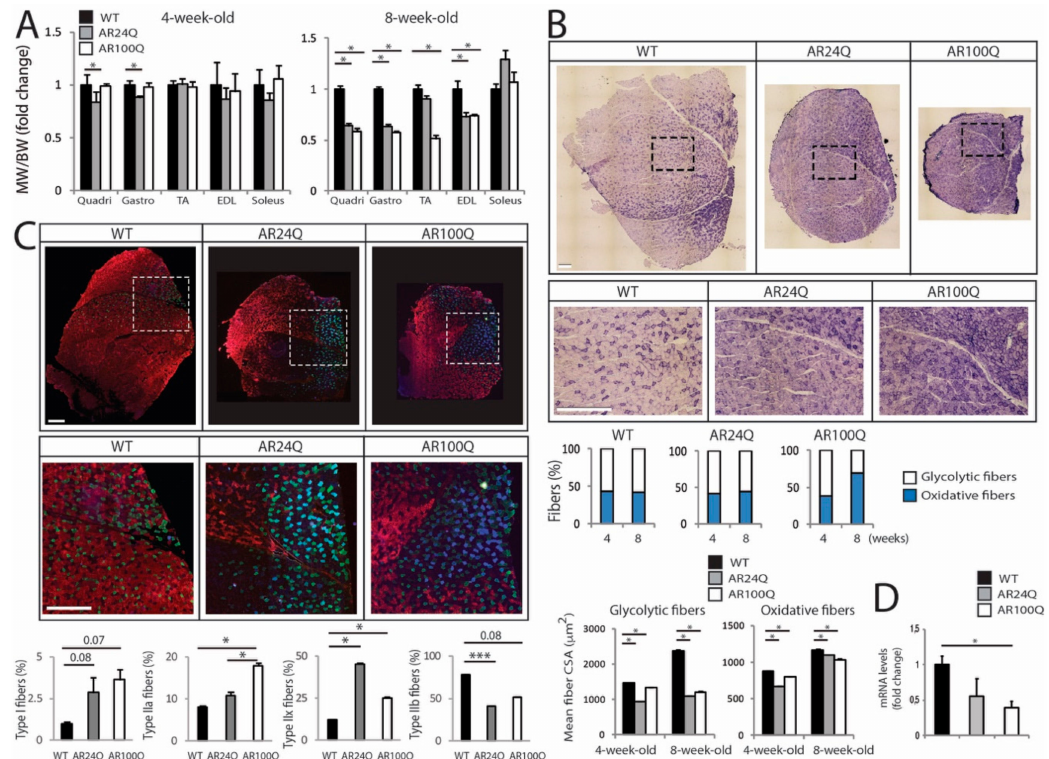
Figure 4. Switch from type IIb to type IIa and IIx fibers and altered muscle metabolism in AR100Q mice. ( A ) Muscle weight (MW) normalized to BW in 8-week-old WT ( n = 14), AR24Q ( n = 7) and AR100Q ( n = 16) male mice. ( B ) NADH analysis of quadriceps and gastrocnemius of 4- and 8-week-old WT, AR24Q and AR100Q male mice ( n = 3). Shown are representative images from 8-week-old mice. Inset position is shown by the dashed square box. Bars, 500 micron. Number of fibers (4-week-old): 1224 WT, 1224 AR24Q and 1237 AR100Q. Number of fibers (8-week-old): 1232 WT, 1257 AR24Q and 1219 AR100Q, all from 3 mice / genotype / age. ( C ) Immunofluorescence analysis of MyHC type I (blue), IIa (green), IIx (black) and IIb (red) from 8-week-old AR24Q and AR100Q male mice ( n = 3). Shown are representative images. Inset position is shown by the dashed square box. Bars, 500 micron. ( D ) Real-time PCR analysis in the quadriceps of 8-week-old WT, AR24Q and AR100Q male mice ( n = 3–4). Graphs, mean ± SEM. Statistical testing: One-way ANOVA followed by Newman-Keuls post-hoc test; * p <